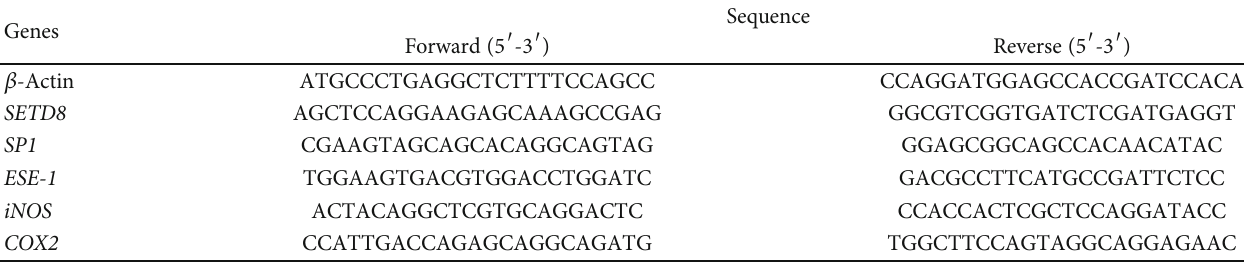
Table 1: Sequences of